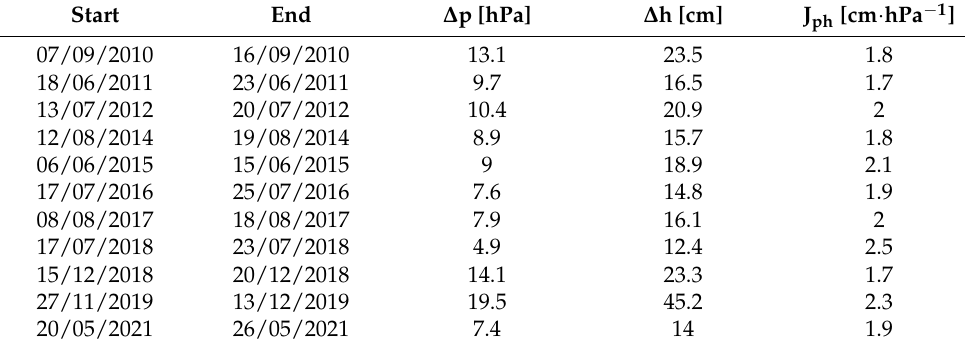
Table 1. Significant events occurred since 2010 in the port of Livorno.